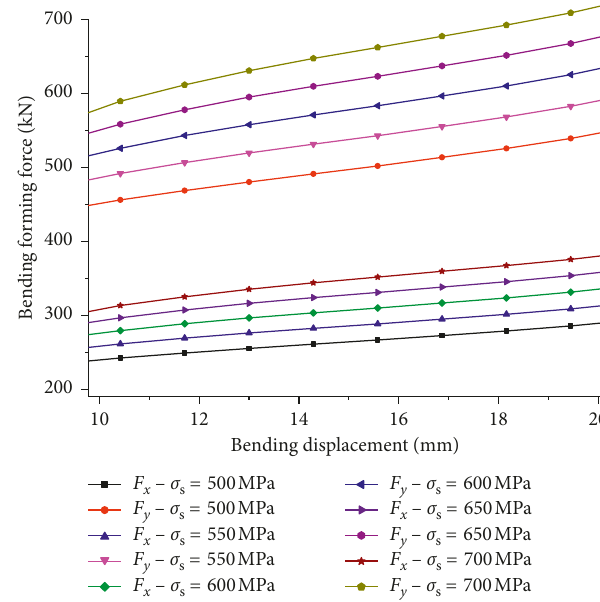
Figure 4: Partial enlargement of Figure 3.